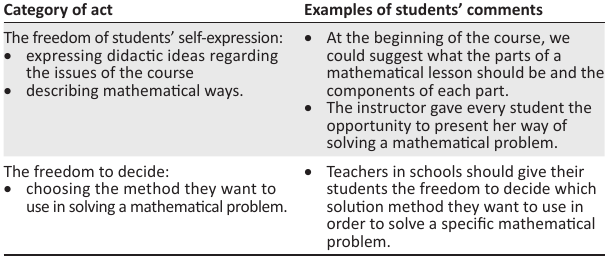
TABLE 3 : Didactic acts promoting freedom.